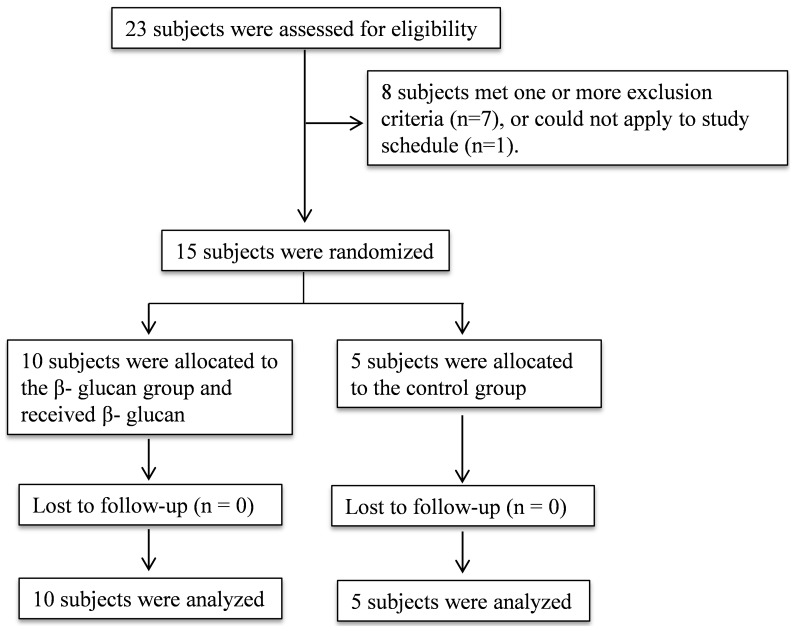
CONSORT flowchart.